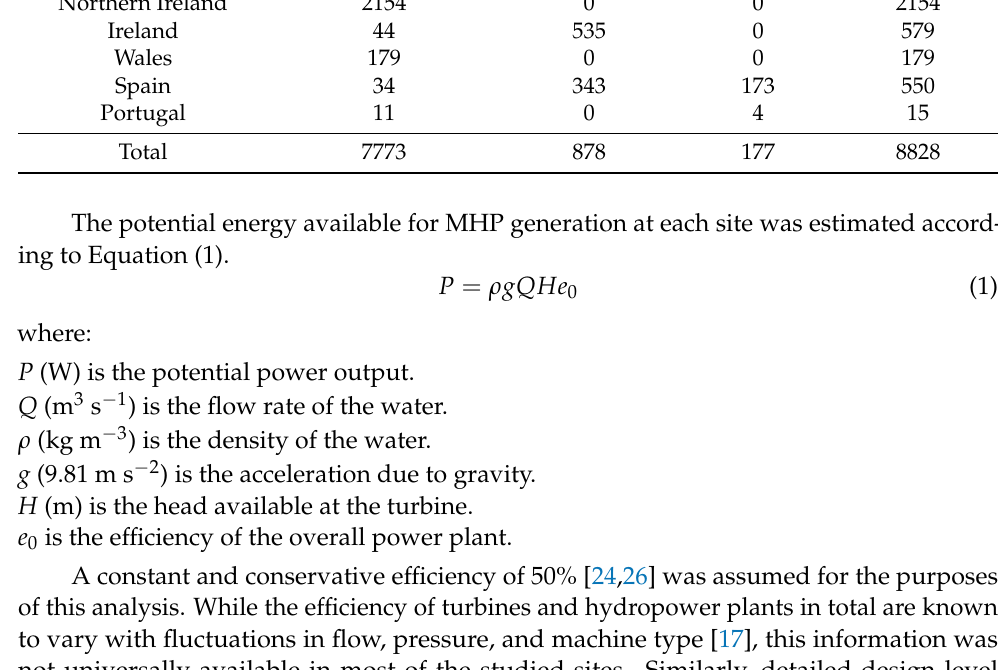
Table 1. Number of potential sites for micro-hydropower (MHP) energy recovery across the six selected EU countries: data collected by sector. Country Drinking Water Wastewater Irrigation Total Scotland 5351 0 0 5351 Northern